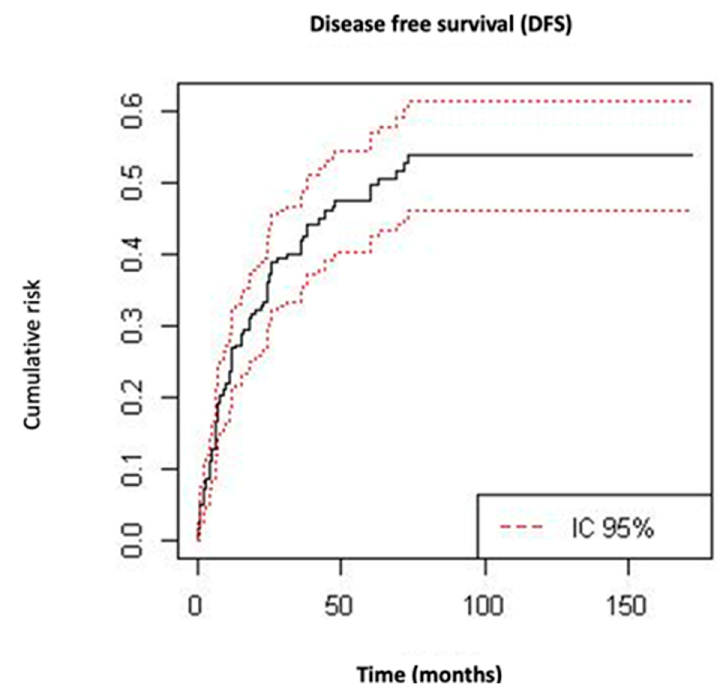
Figure 2. Kaplan–Meier curves for disease-free survival.